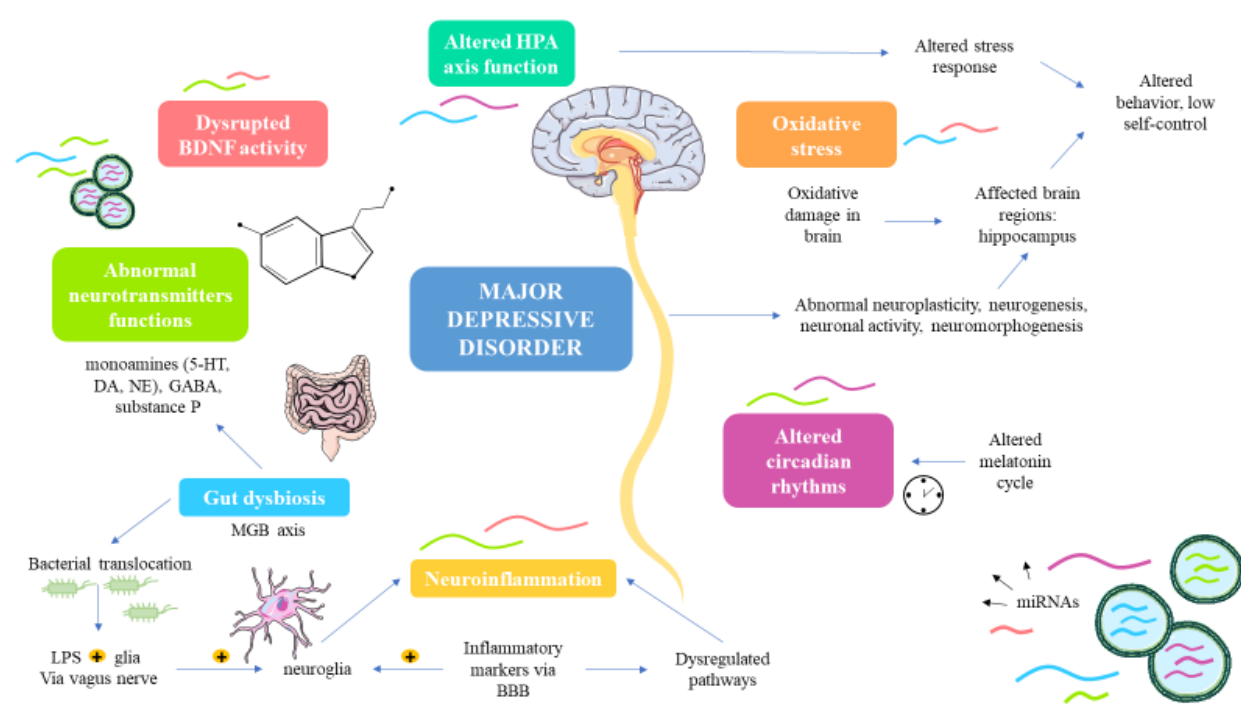
Figure 1. Mechanisms involved in the etiopathogenesis of MDD in which miRNAs may be key mediators BBB: blood brain barrier. 5-HT: serotonin. DA: dopamine. NE: norepinephrine. GABA: gamma-aminobutyric acid. MGB axis: microbiota-gut-brain axis. HPA axis: hypothalamic-pituitary-adrenal axis. Kyn: kynurenine. LPS: lipopoly- saccharide.